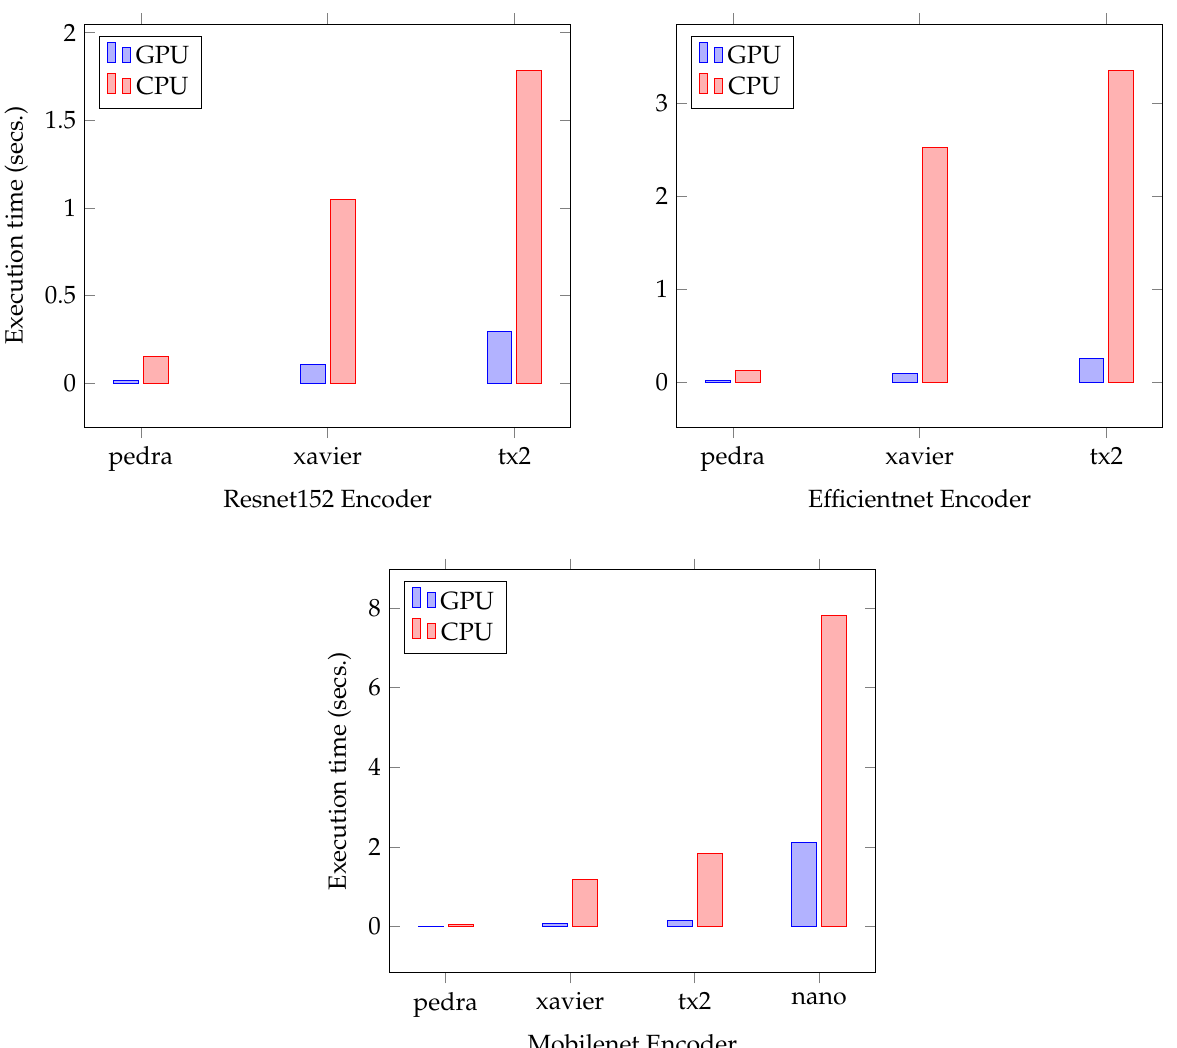
Figure 11. PSPNet architecture inference time comparative with all encoders. Figure 12 follows the same structure as Figure 11, but showing the UNET execution times with all encoders. This network is the one that shows the most limitations in terms of execution, where only the MobileNet encoder was able to be executed in all the devices, and where the execution times are higher than in the other two models. In the first graph, with ResNet, the execution in the Jetson Nano platform was not possible, and in TX2 only when using the GPU, and with a time overhead close to the second. In the EfficientNet encoder, it was only possible to perform the execution in the Xavier platform, with a remarkable CPU time of 14 s per image. MobileNet was executed on all devices using GPU, while the Jetson Nano device could not be executed on